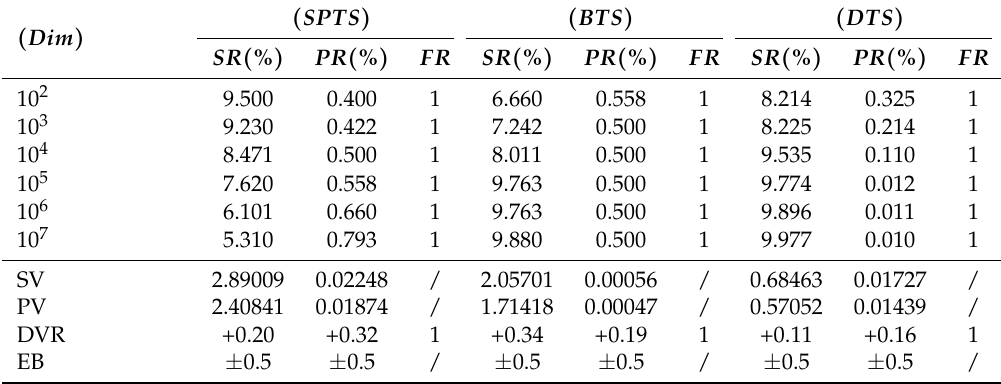
Table 1. Quantum simulation of high-dimensional data tables describing the three topological structures of the DE algorithm implied in β -Hilbert space about Dim